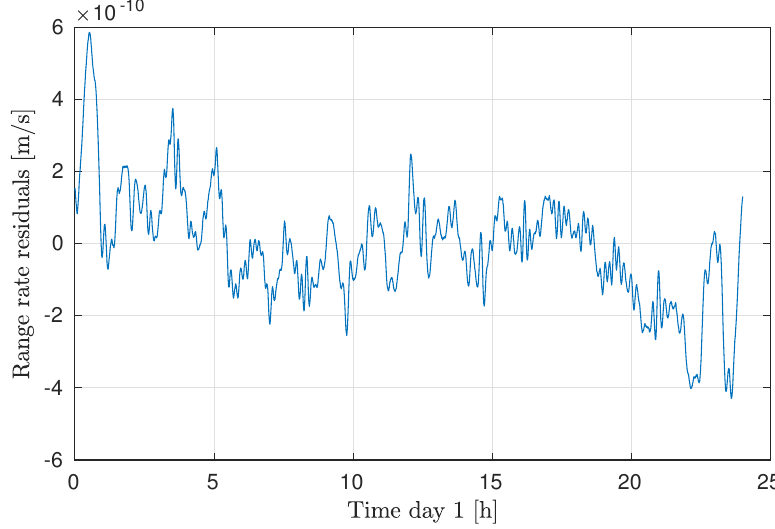
Figure 5. Time series of range rate residuals for Day 1 after the last (28th) iteration.